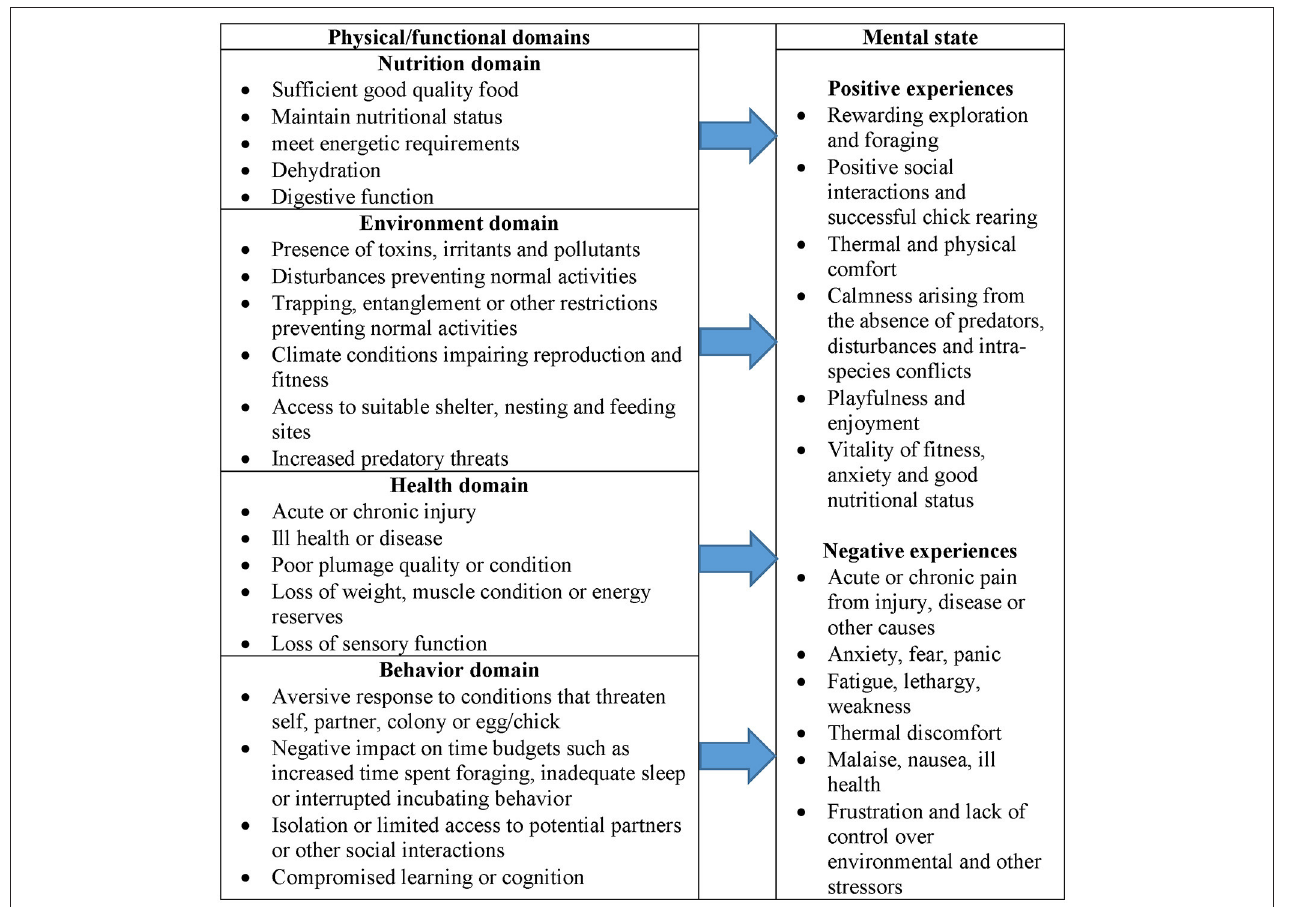
FIGURE 1 | Penguin welfare assessment